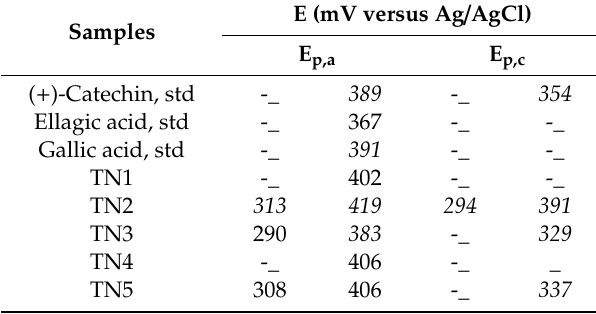
Figure 2. Cyclic voltammograms (background subtracted) for the couples: proanthocyanidin TN12 / ( + ) – catechin; ( a ) ellagitannin TN6 / ellagic acid; ( b ) gallotannin TN14 / gallic acid; ( c ) in the model wine solution, measured at 100 mV / s above the potential range: − 200 mV to 1000 mV, at a 3 mm glassy carbon electrode. Table 1. Anodic (E p,a ) and cathodic (E p,c ) peak potentials obtained by scanning tannin solutions in the range of − 200 mV to 500 mV. The redox couples obtained by reversible processes are labelled in italics. A detailed description of tannin samples (TNs) according to the information by suppliers is provided in Table 4 of the ‘Materials and Methods’